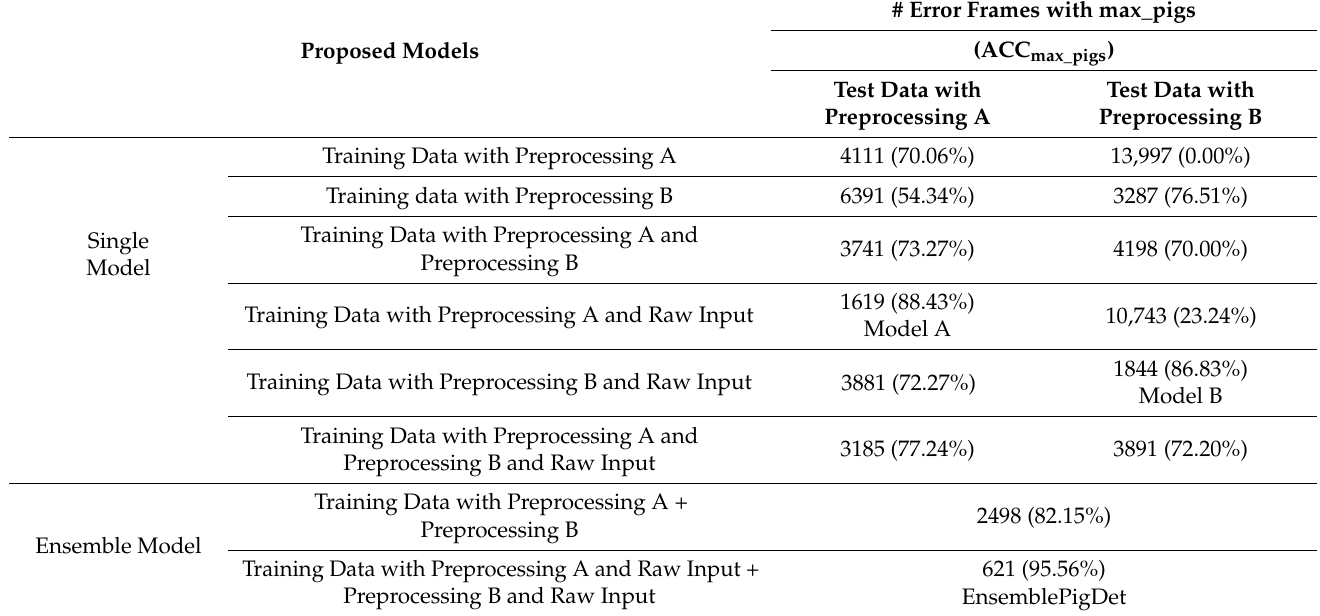
Table 6. Comparison of accuracy ACC max_pigs for 13,997 key frames with overexposed regions (obtained during 8:30 a.m. to 10:30 a.m.) with different training data.